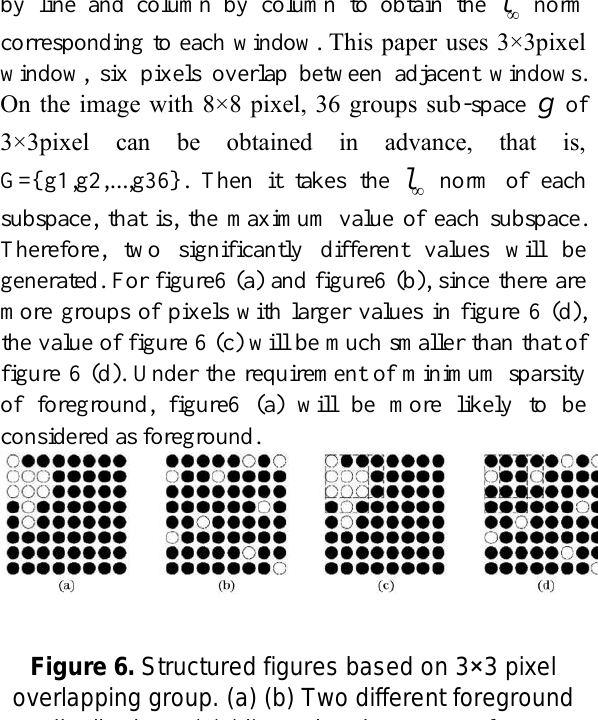
Figure 6. Structured figures based on 3×3 pixel overlapping group. (a) (b) Two different foreground distributions; (c) (d) overlapping group of two different